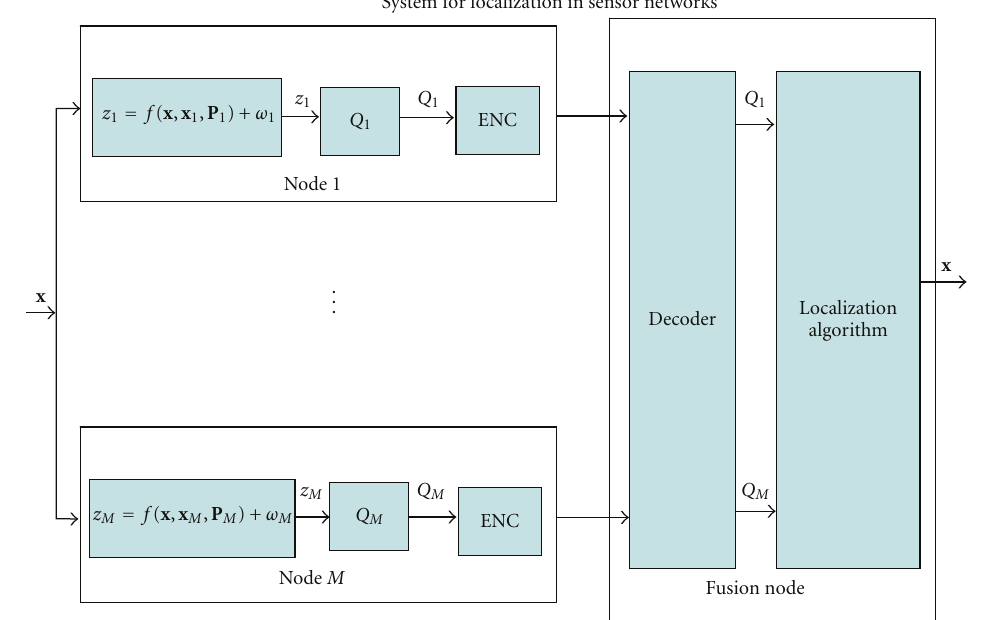
Figure 1: Block diagram of source localization system. We assume that the channel between each node and fusion node is noiseless and each node sends its quantized (Quantizer, Q i ) and encoded (ENC block) measurement to the fusion node, where decoding and localization are conducted in a distributed manner.